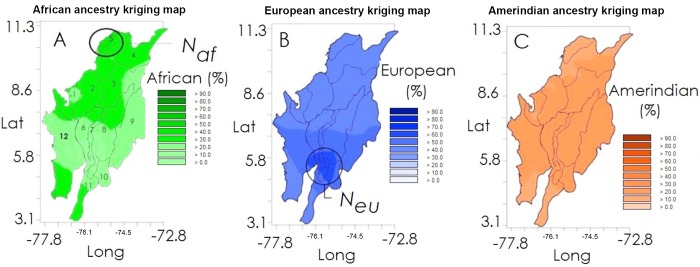
(A) Geographic distribution of African (green), (B) European (blue), (C) Amerindian (orange) ancestry based on individual estimates.To facilitate comparison, color intensity transitions occur at 10% ancestry intervals for all maps. Maps were obtained using Kriging interpolation (see Materials and Methods).